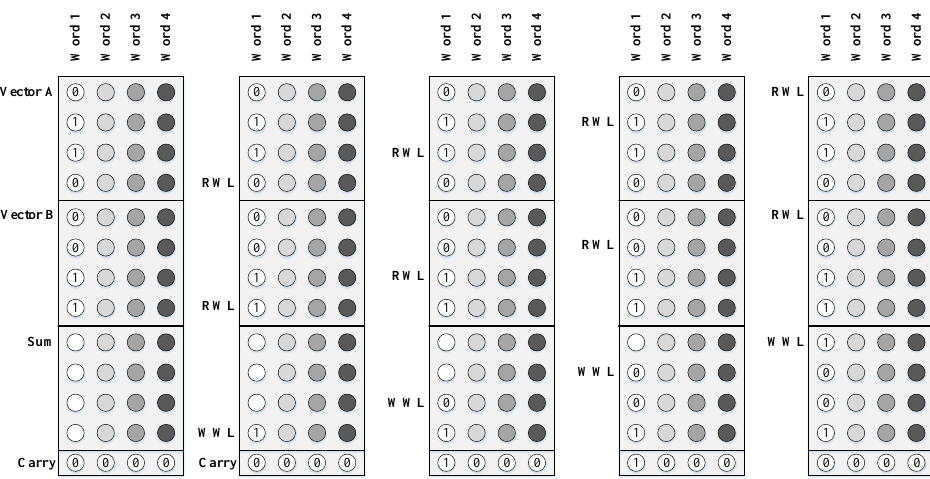
Figure 14. Example of an addition operation in Neural Cache (adapted from